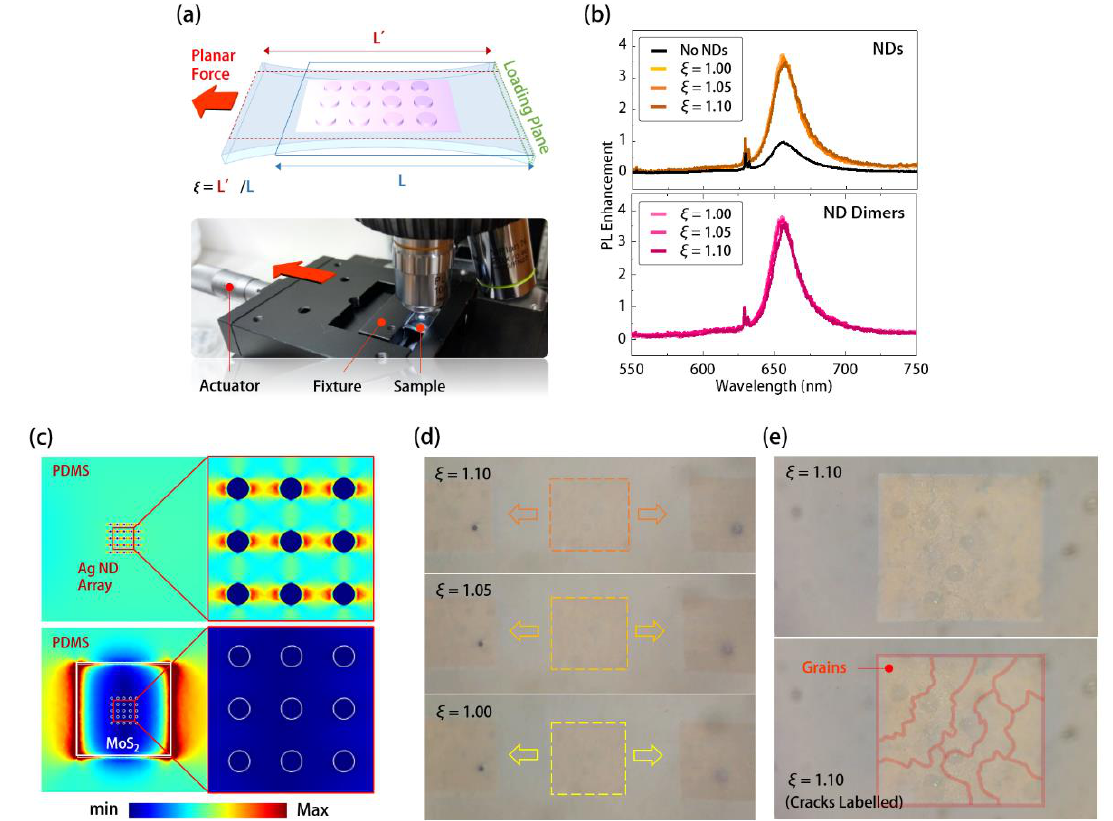
Figure 5. ( a ) (top) Schematics of stretching sample in measurement and simulation, definition of stretching strain ξ , and (bottom) picture of the stretching stage in PL and Raman spectra measurement system; ( b ) the measured PL spectra of the MoS 2 covered with silver ND (top, D = 110 nm) and ND-dimer (bottom, D = 100 nm) arrays in PDMS under different stretching strains ξ from 1.0 to 1.1; ( c ) theoretical strain distributions along the planes of the silver ND arrays with (bottom) and without (top) MoS 2 coverage in PDMS under an applied ξ of 1.1 along the X -axis; ( d ) the OM images of silver ND array covered with MoS 2 under the applied ξ from 1.0 to 1.1; ( e ) high magnification OM images of MoS 2 (with and without crack labels) with silver ND array under an applied ξ of 1.1 along the X -axis.